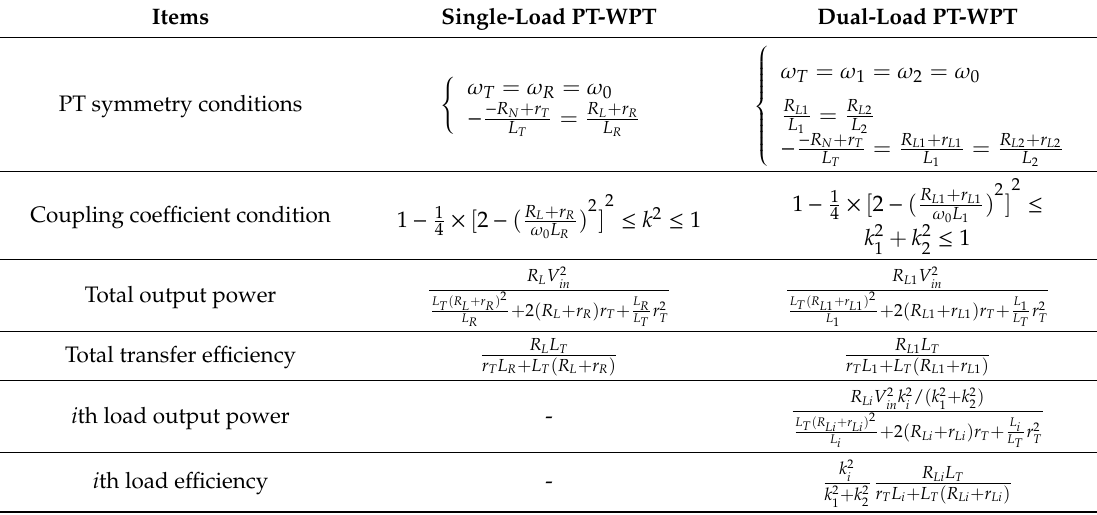
Table 1. Comprehensive comparison of single-load PT-WPT and dual-load PT-WPT system (working in the strong coupling region and i = 1,